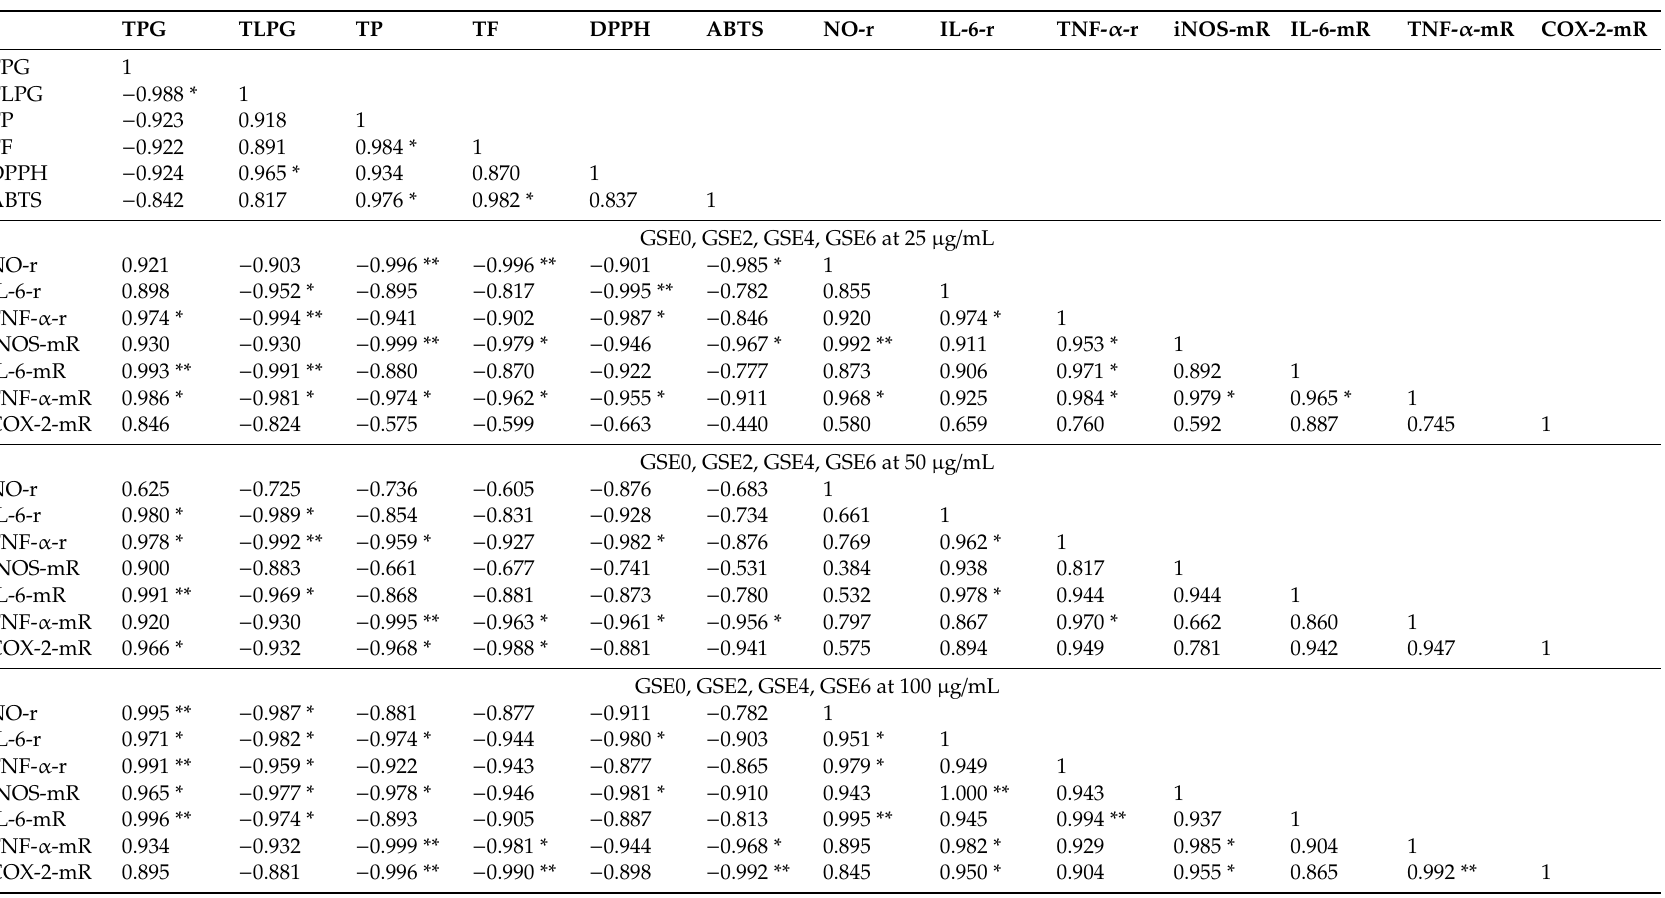
Table 4. Correlations among total polar ginsenosides, phenolic compounds, total less-polar ginsenosides, antioxidant capacities, and inflammatory factors at various concentrations of